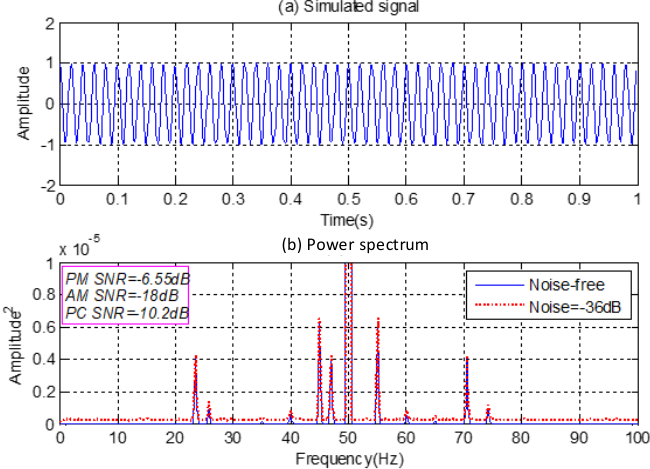
Figure 1. Simulated signals ( a ) and their power spectra ( b ).